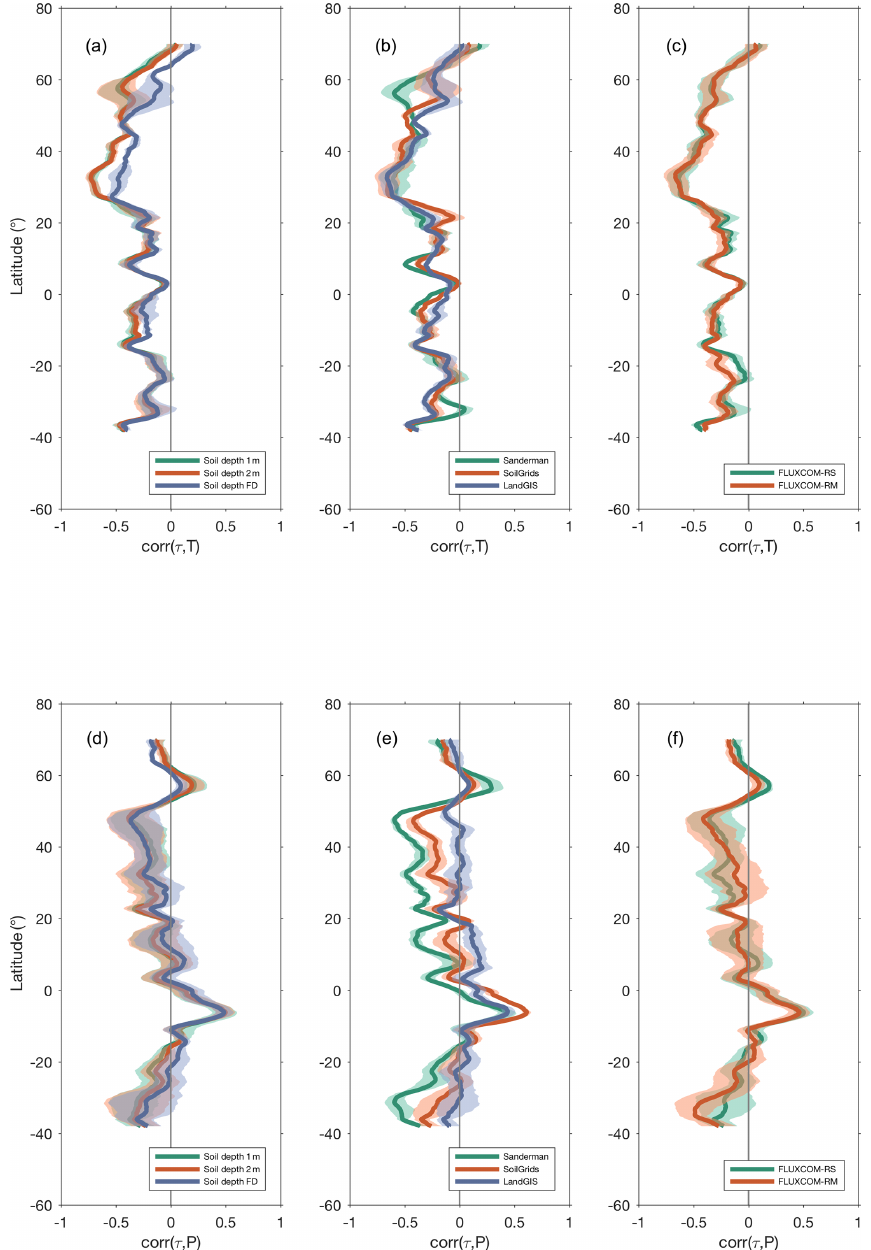
Figure 8. Correlation between zonal τ and mean annual temperature ( T ) and between τ and mean annual precipitation ( P ). Panels (a) and (d) are colored according to different soil depth (1m, green; 2m, red; full soil depth, blue) with shaded areas being the interquartile range. Panels (b) and (e) are colored according to different soil sources. Panels (c) and (f) are colored according to different GPP products of different forcing (remote sensing only and remote sensing plus meteorology). The correlations are consistent across the different latitudinal span widths considered (see Sect. 3.5) and hence are not shown